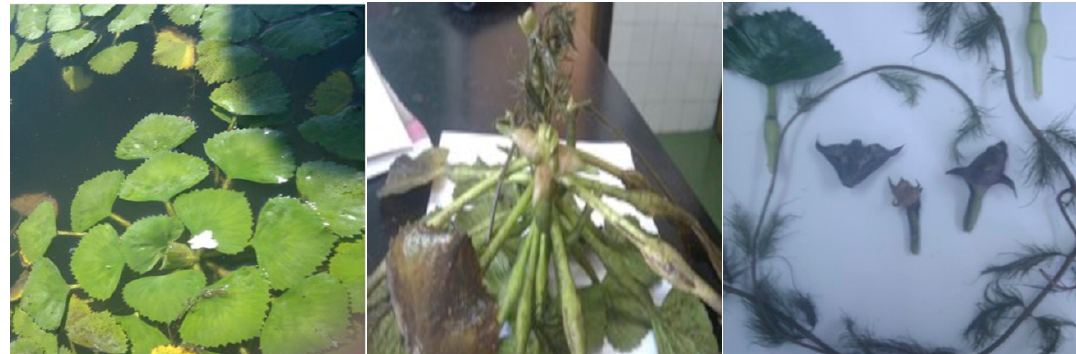
Figure 9. Illustrative photos of typical rosettes, leaves, and stem of Trapa natans L.